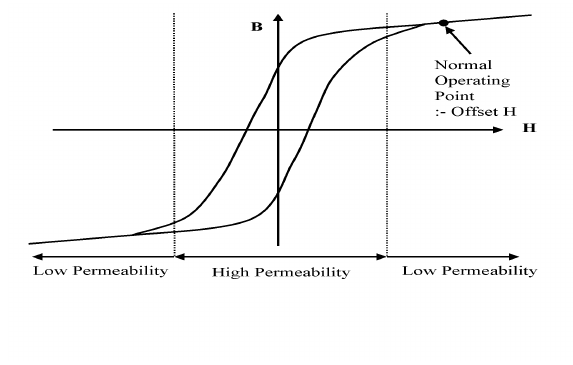
Figure 3: Proposed Model Structure